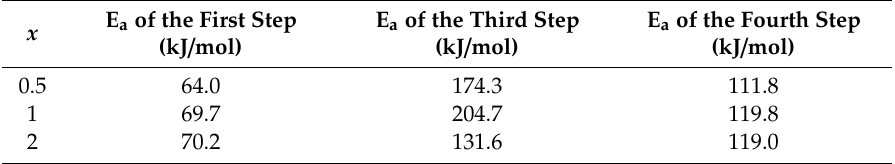
Figure 5. DSC curves ( a , c , e ) at di ff erent heating rates and the Kissinger spectra ( b , d , f ) that ln( β / T m2 ) as a function of T m − 1 for the decomposition steps of the LiBH 4 / x LiAlH 4 ( x = 0.5, 1, 2) samples. Table 1. The activation energy (E a ) of the first, third and fourth dehydrogenation steps of LiBH 4 / x LiAlH 4 ( x = 0.5, 1, 2) samples.